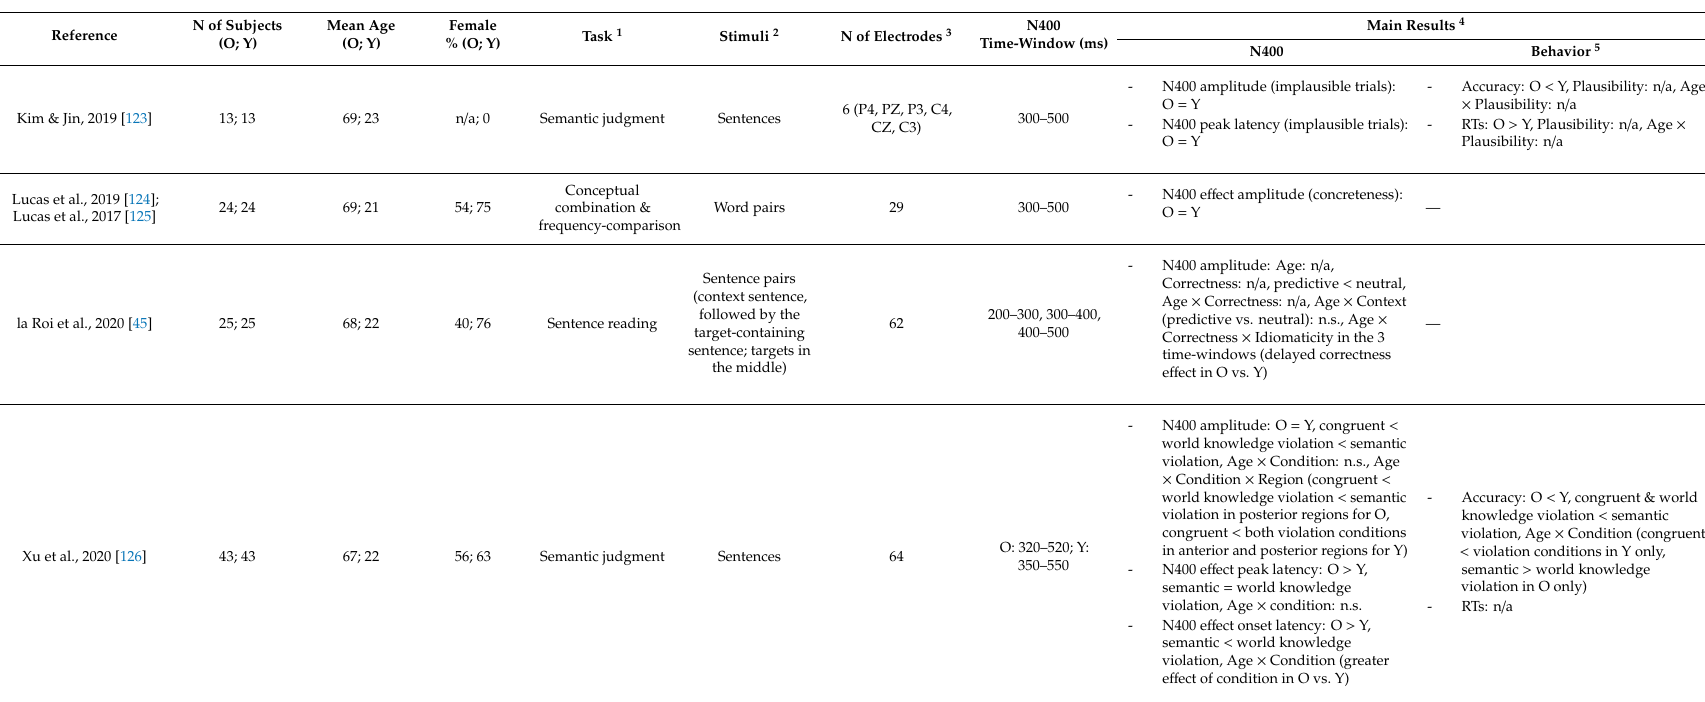
N400amplitude(implausibletrials): O = Y